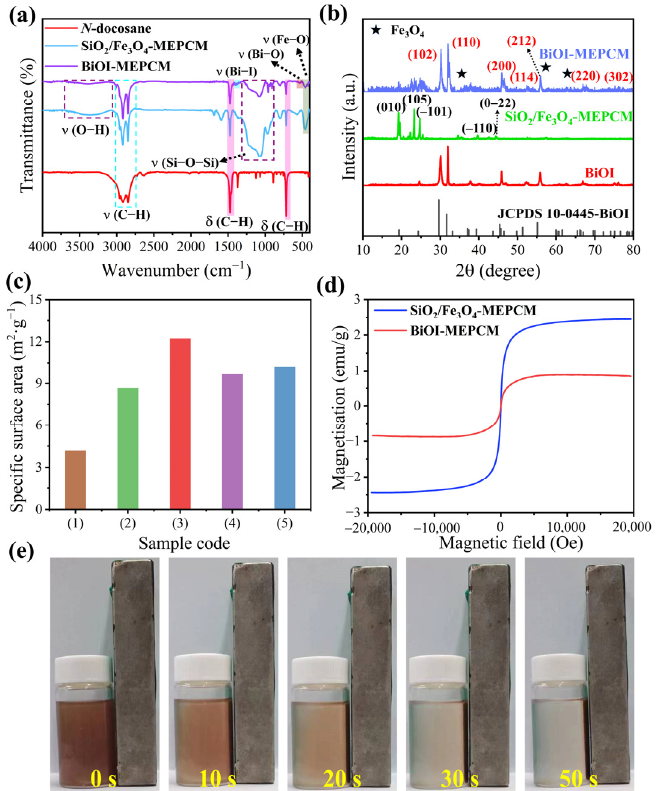
Figure 4. ( a ) FTIR spectra and ( b ) XRD patterns of n -docosane, pure BiOI, and phase-change micro- capsules. ( c ) Specific surface area of (1) SiO 2 /Fe 3 O 4 -MEPCM, (2) pure BiOI, (3) BiOI-MEPCM (0.5:1),